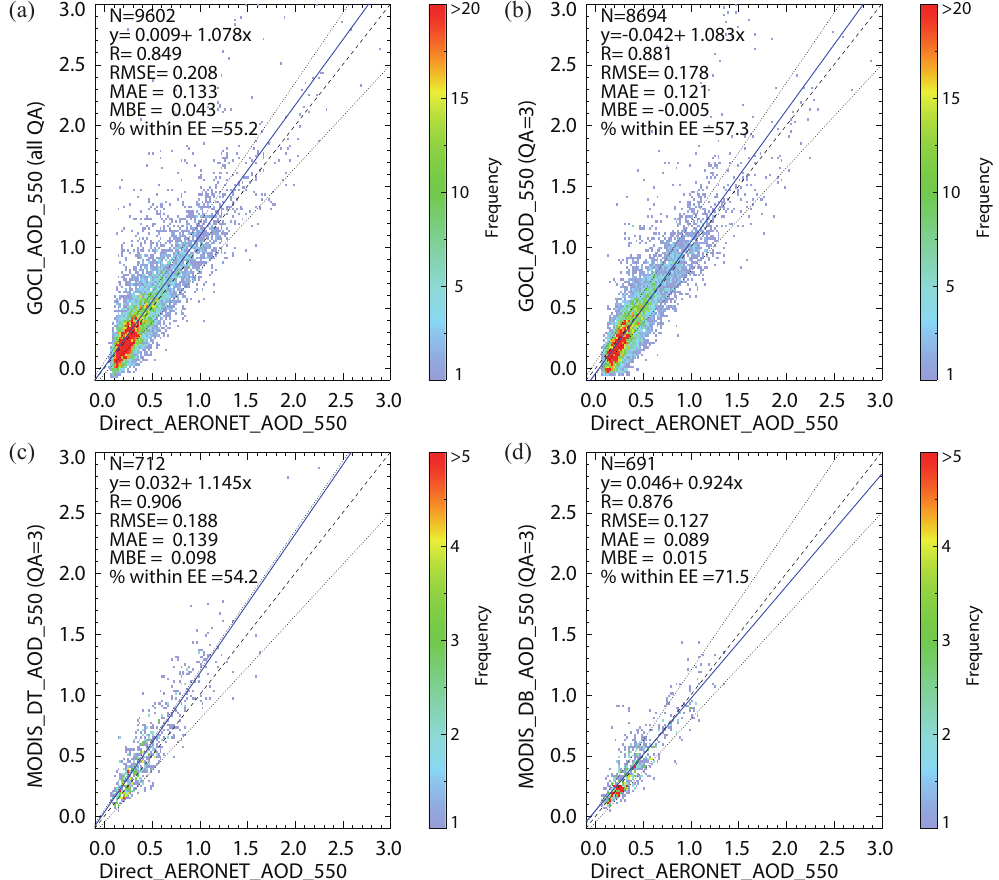
Figure 8. Comparison of AOD between AERONET and (a) GOCI for all QA, (b) GOCI for QA = 3 only, (c) MODIS DT, and (d) MODIS DB. Colored pixels represent a bin size of 0.02. The blue solid line is the linear regression line. Black dashed and dotted lines denote the one-to-one and expected error lines,